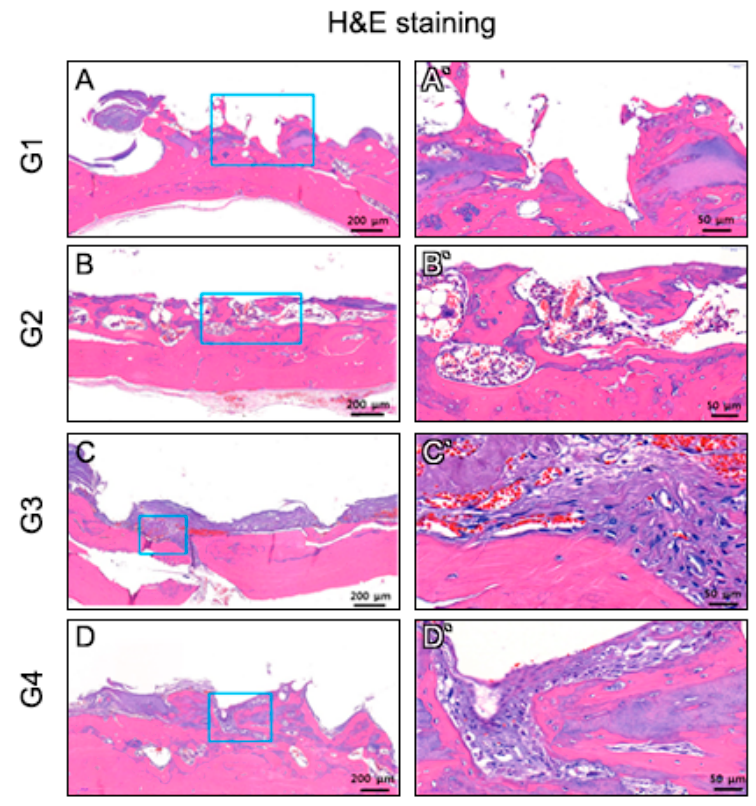
Figure 5. H&E staining of decalcified cross-section samples. In decalcified tissue specimen, fibrous connective tissue was not observed in the seeding group ( A , B ). On the contrary, well-organized fibrous connective tissue was apparent in the cell printing group ( C , D ).